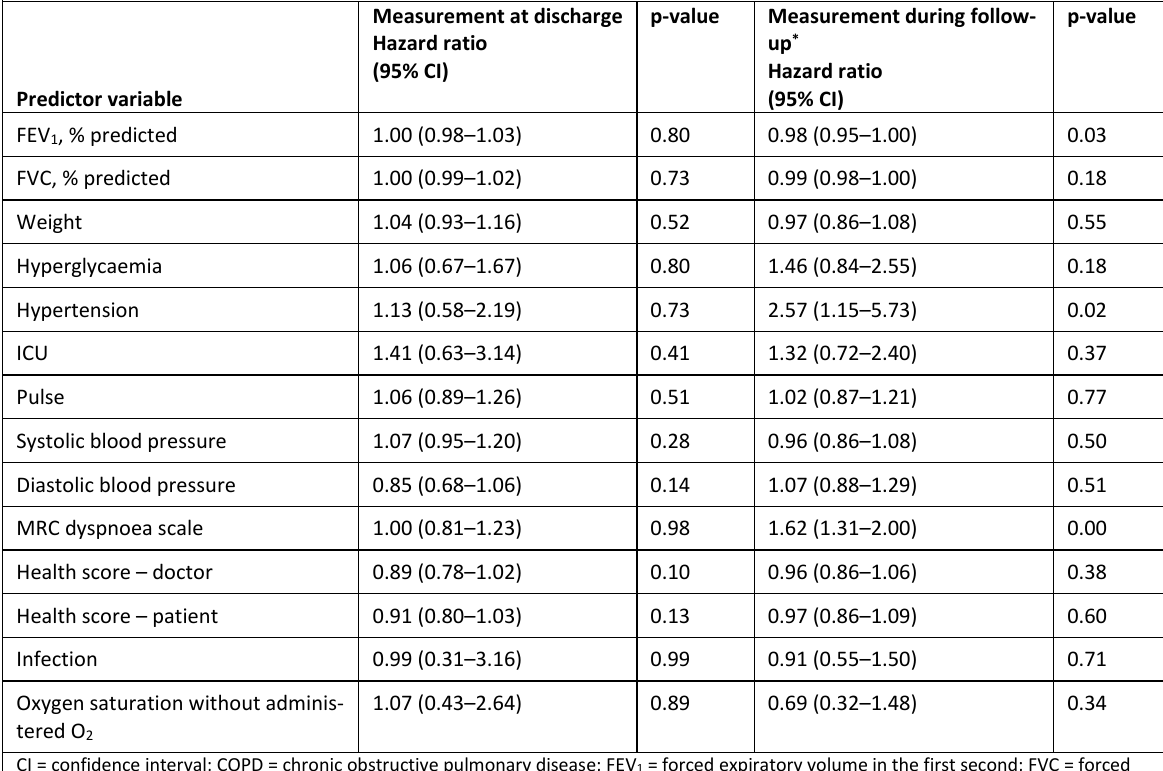
Table 6: Hazard ratios of re-exacerbation and/or death associated with the p-values of predictor variables at discharge and during